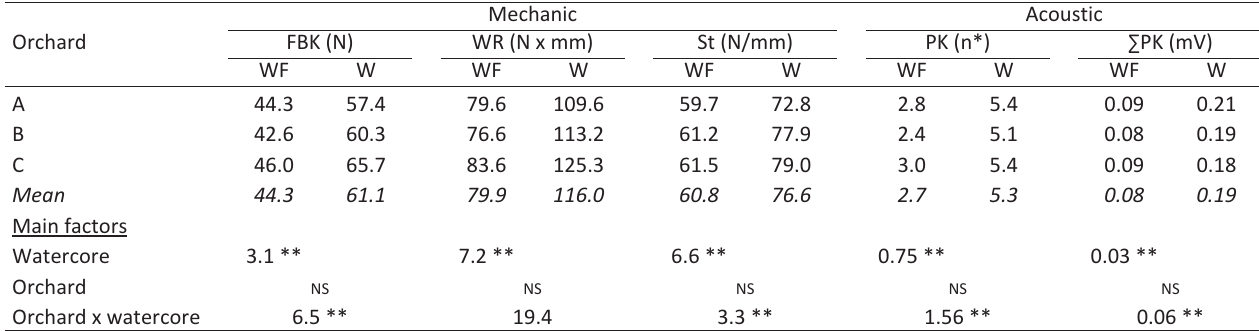
Table 4 ­ Mechanical and acoustic parameters of watercore­free (WF) and watercore (W) fruit of ‘Pomella Genovese’ Mechanic Acoustic Orchard